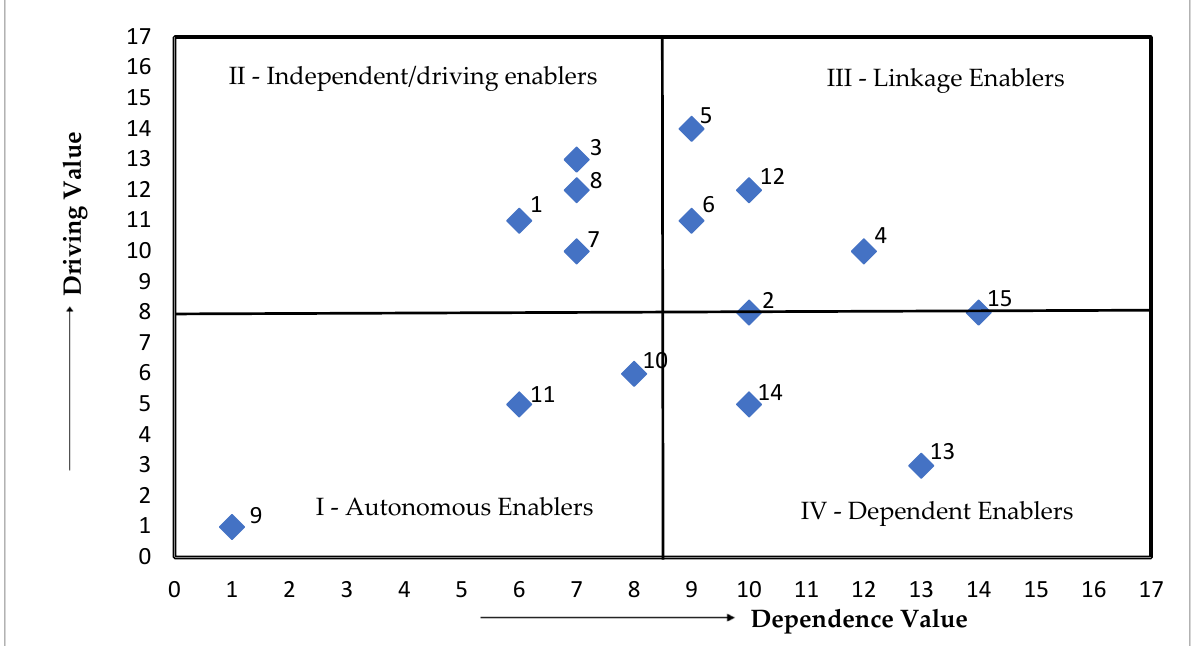
Figure 4. Enabler’s classification utilizing MICMAC analysis.